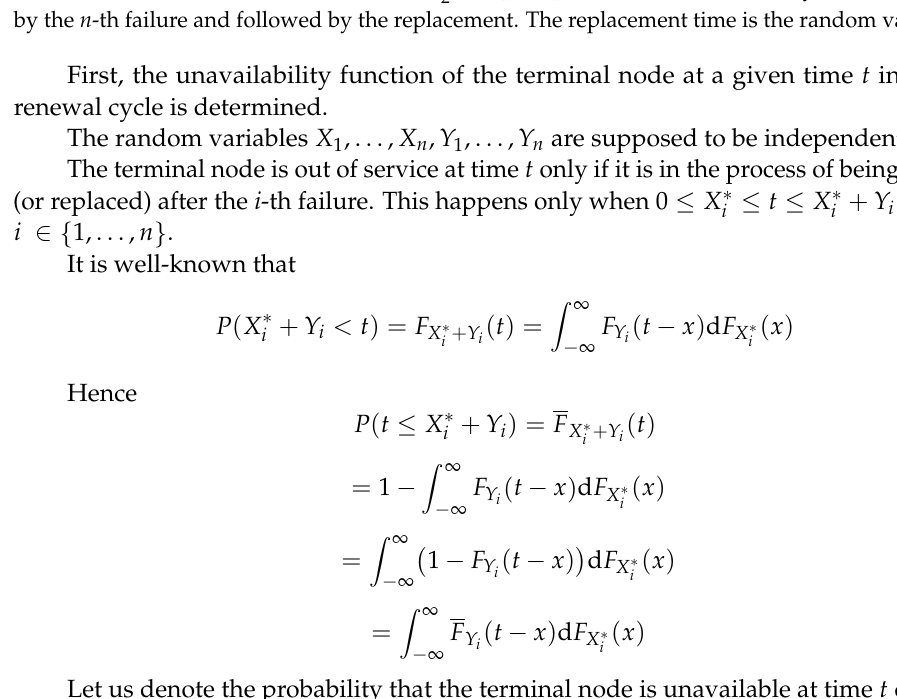
= X + Y + X 2 , etc. The renewal cycle T is terminated 1 1 2